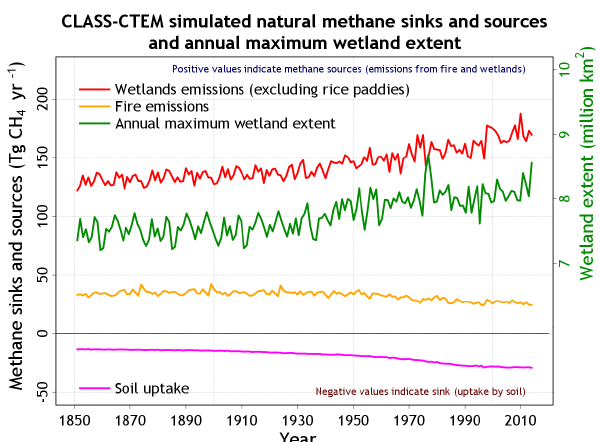
Figure 3. Time evolution of simulated natural methane fluxes (shown on the primary y axis) and annual maximum wetland extent (shown on the secondary y axis) by CLASS-CTEM for the 1851– 2015 period in the transient historical